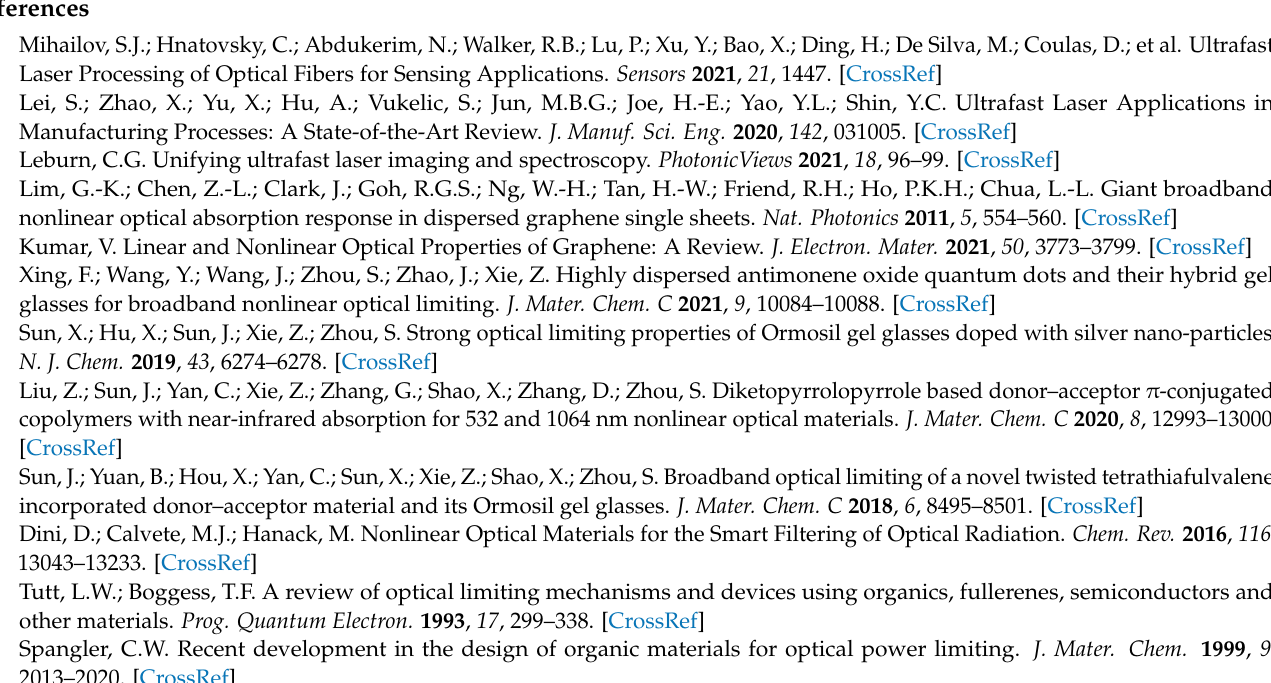
662 nm. The dots represent the experimental data and solid lines were theoretical fitted curves by global analysis; Figure S2: The natural transition orbitals in the first excited state (S1) of designed twistacenes; Figure S3: The emission spectra of PyDN in toluene under different incident laser energies at 400 nm. Insets is that linear dependence of one-photon-excited fluorescence intensity on the laser in-tensity; Figure S4: Fluorescence decay of PyDN in toluene. The solid line was fitted lifetime of 3.5 ns; Figure S5: 1 H NMR spectrum of PyDN ; Figure S6: 13 C NMR spectrum of PyDN ; Figure S7: MALDI-TOF spectrum of PyDN